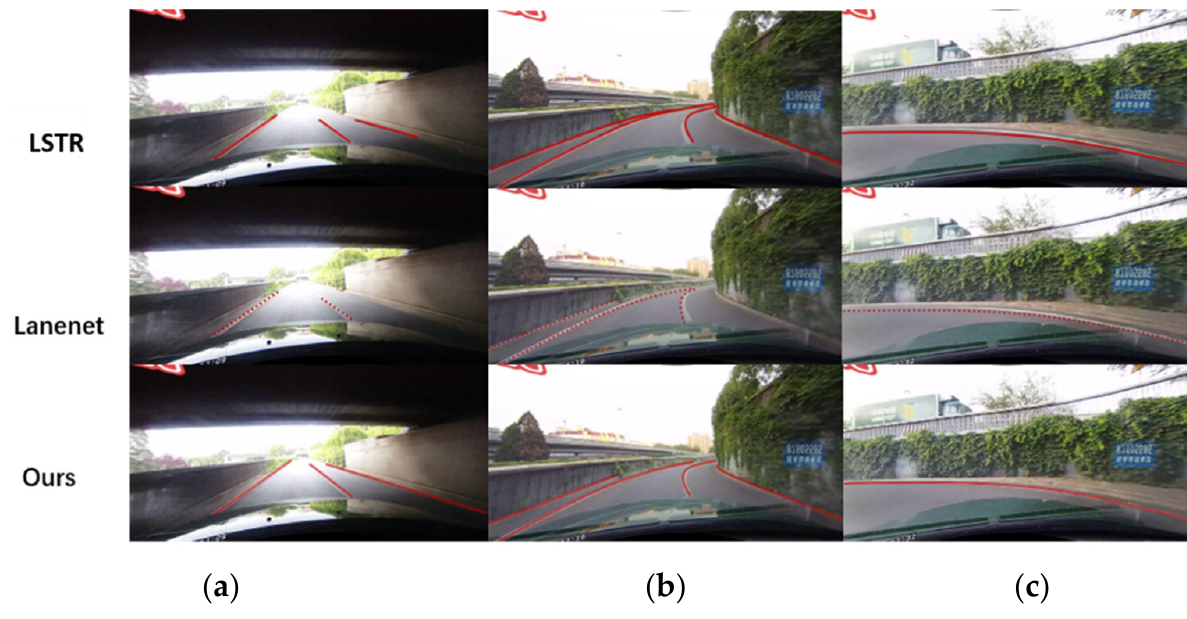
Figure 4. The pictures on the CULane dataset to verify the performance of our model. From top to bottom, the model visualization effects of LSTM, Lanenet, and our method are shown. ( a ), ( b ), ( c ) is the model inference results of the tunnel exit, curve, and curve with large curvature, respectively.